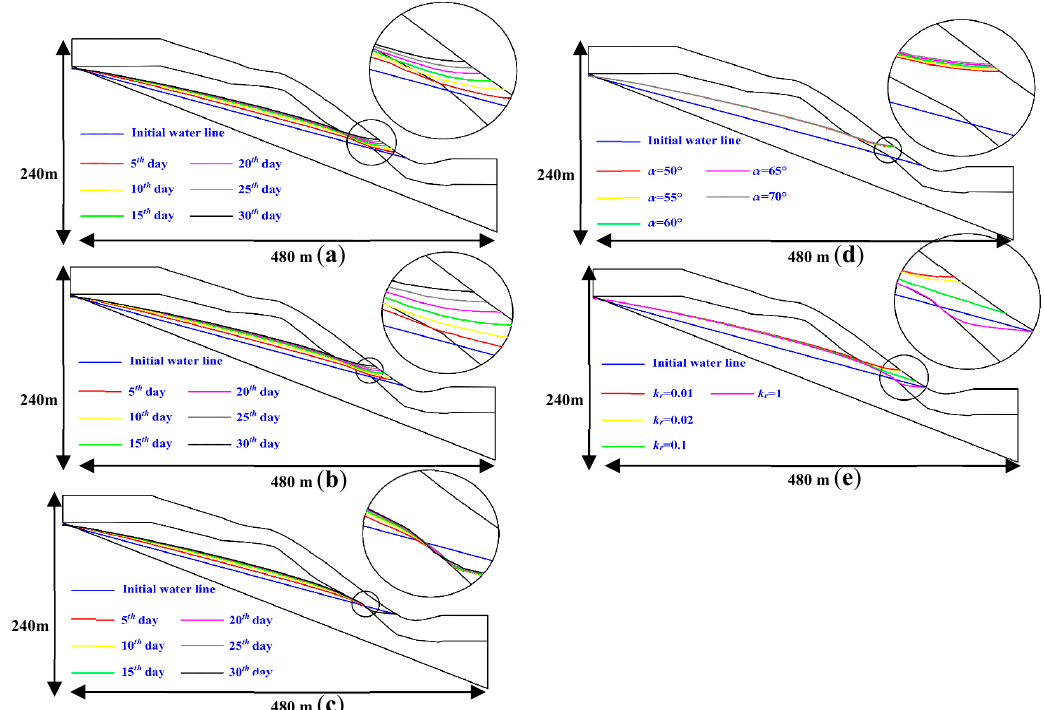
Figure 10. Variations in the groundwater levels: ( a ) k r = 0.01, α = 50° during rainfall; ( b ) k r = 0.01, α = 70° during rainfall; ( c ) k r = 1 during rainfall; ( d ) different α values with k r = 0.01 after rain had ceased; ( e ) different k r values with α = 70° after rain had ceased.